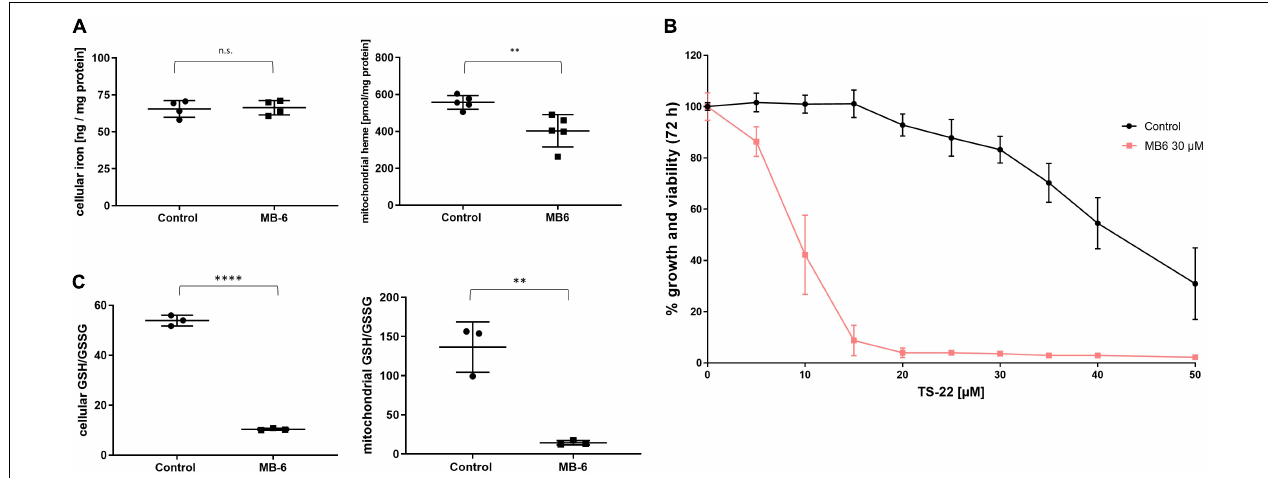
FIGURE 3 | MB-6 treatment lowers mitochondrial heme levels as well as cellular and mitochondrial GSH/GSSG ratios and results in increased sensitivity to iron chelators. (A) MB-6 treatment does not alter total cellular iron content (left) but significantly decreases total mitochondrial heme content by almost 30% (right). (B) Co-treatment with the iron chelator TS-22 reveals increased sensitivity of MB-6 treated cells toward iron depletion. (C) Both cellular (left) and mitochondrial (right) GSH/GSSG ratios are significantly decreased in MB-6 treated cells. ∗∗ p < 0.01, ∗∗∗∗ p <